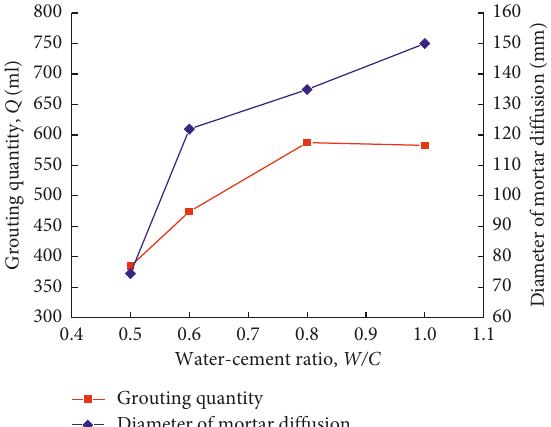
Figure 14: Characteristics of slurry diffusion ( P � 0.2MPa, k 1 �